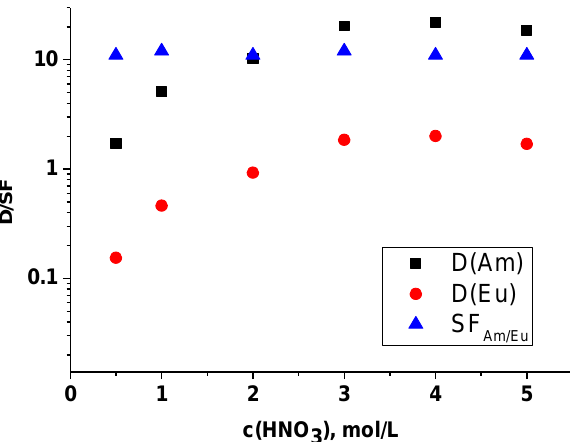
Figure 5. Dependence of americium and europium distribution ratios and selectivity factor on nitric acid content. Organic phase-0.05 mol/L ligand in F-3 solvent.